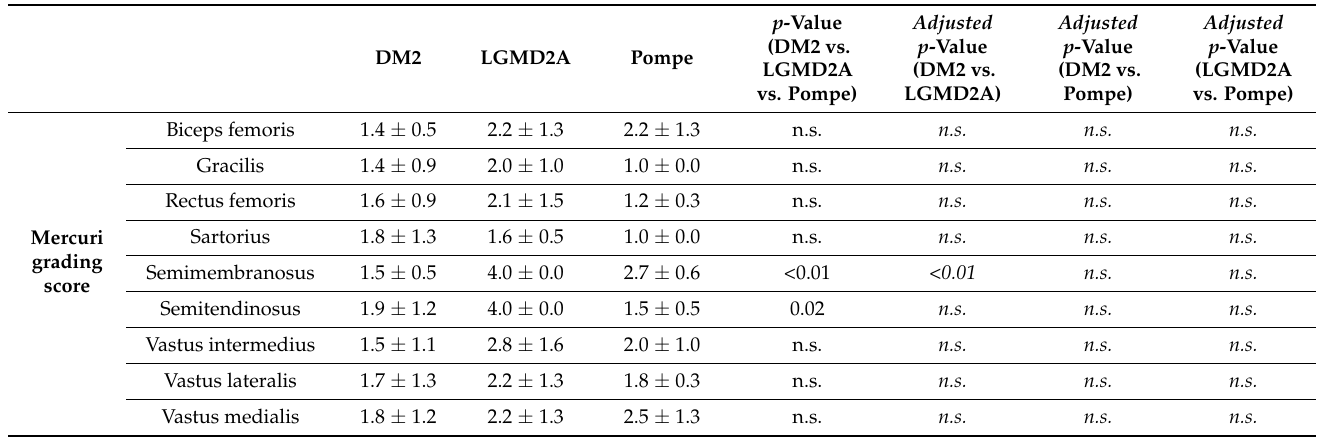
Table 4. Mercuri grading scores of fatty infiltration for muscles in the thigh region. Table showing Mercuri scores for the biceps femoris, gracilis, rectus femoris, sartorius, semimembranosus, semitendinosus, vastus intermedius, vastus lateralis, and vastus medialis muscles based on the T 2 -weighted two-dimensional (2D) DIXON turbo spin echo (TSE) fat images. Values are given as mean ± standard deviation. P -values for the comparison of the three groups as well as adjusted p -values (derived from post-hoc testing, italics ) are shown (n.s.: not statistically significant, p > 0.05). p -Value (DM2 DM2 LGMD2A Pompe